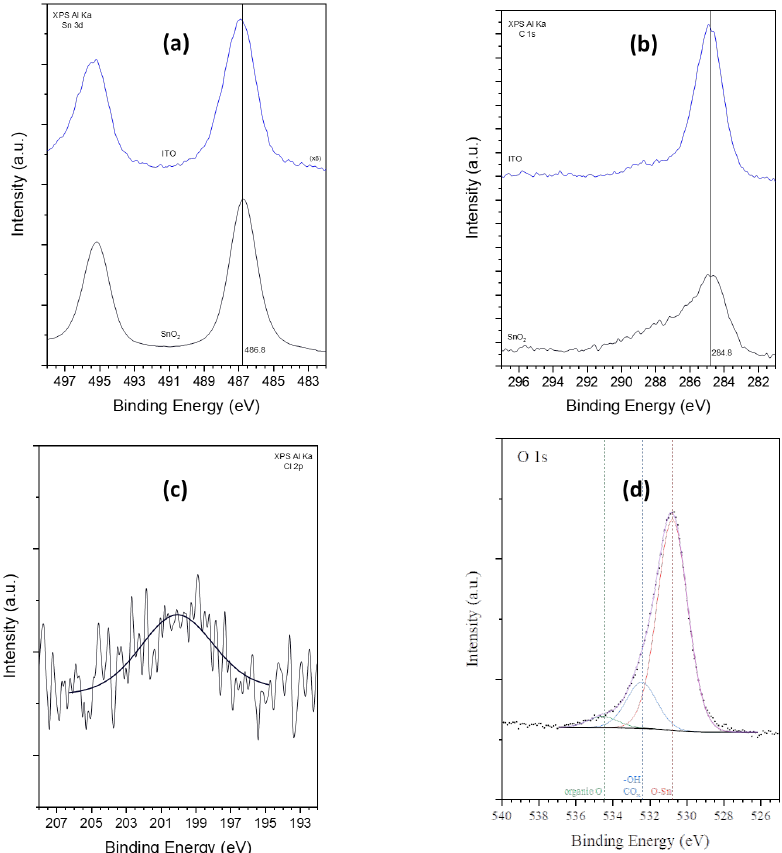
Figure 11. XPS spectra for ( a ) Sn-3d, ( b ) C-1s, ( c ) Cl-2p and ( d ) O-1s.